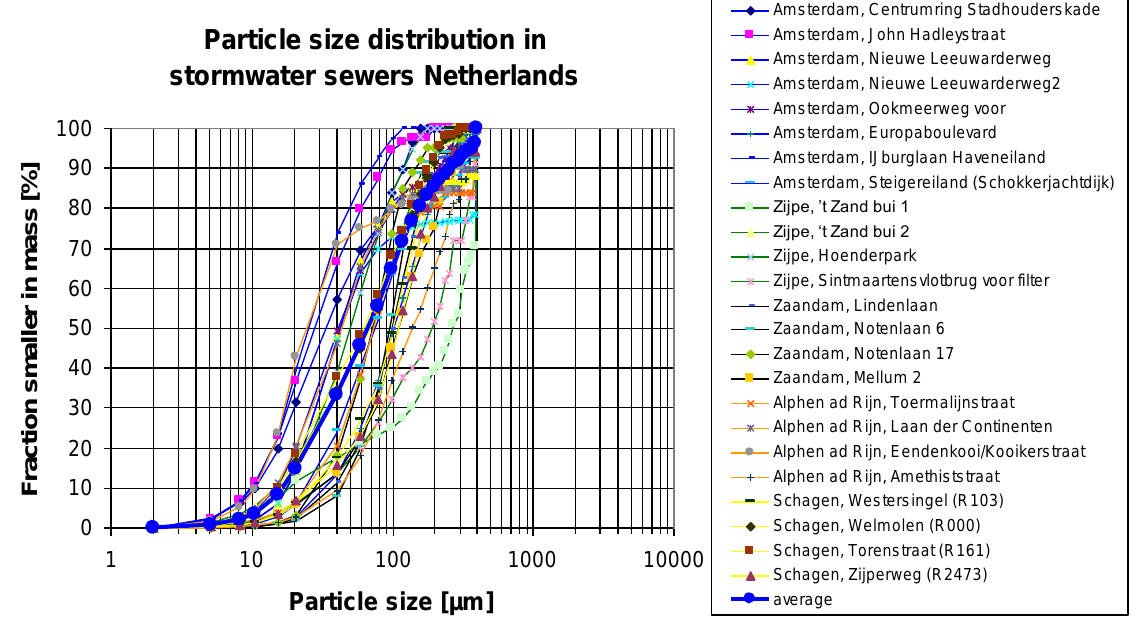
Figure 3. Particle size distributions in several Dutch stormwater sewer